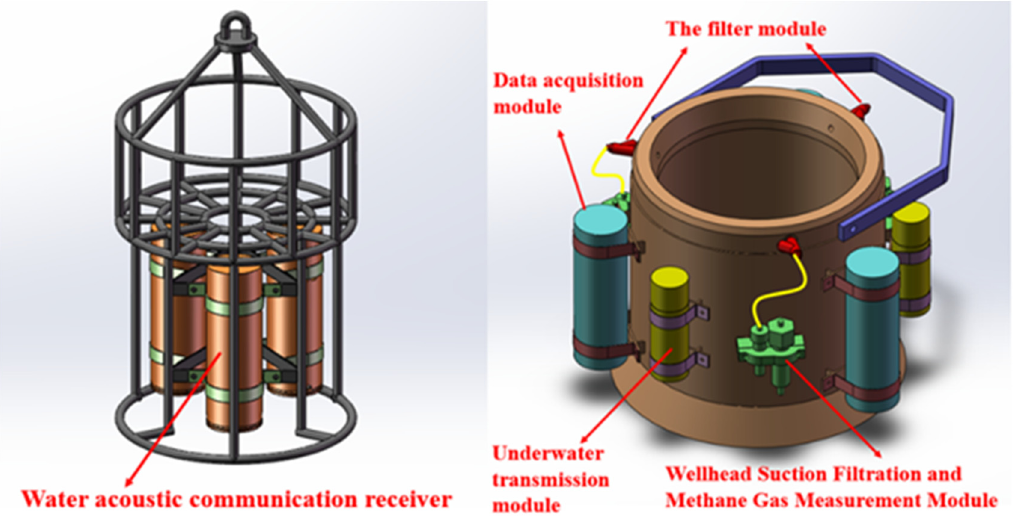
Figure 2. System architecture diagram.